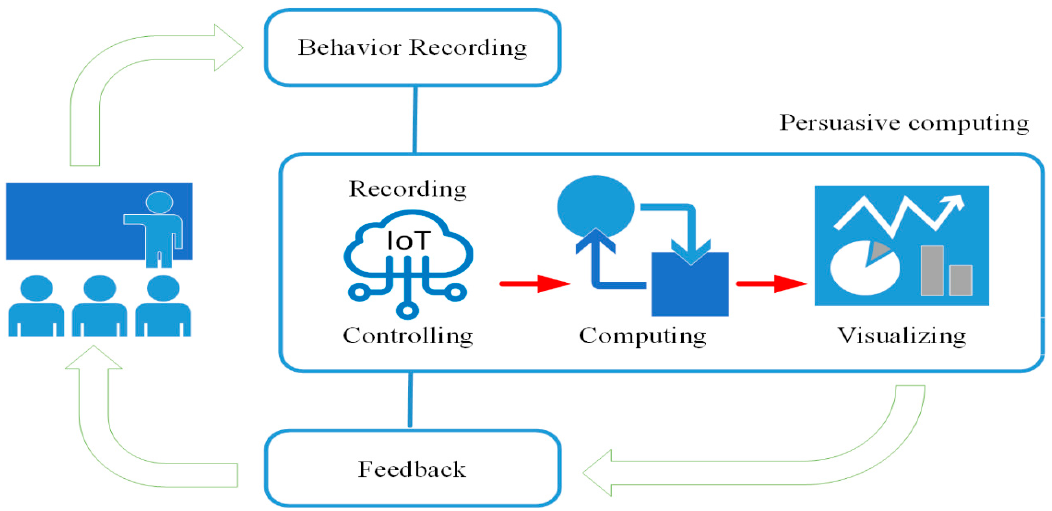
Figure 1. The concept of persuasive computing.